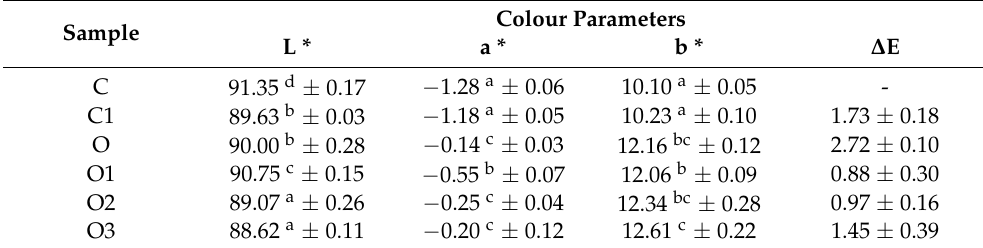
Table 2. Colour parameters and the total colour difference parameter in yoghurts obtained without or with the addition of tea. C, control; C1, control with 6% inulin; O, oolong tea; O1, oolong tea with 3% inulin; O2, oolong tea with 6% inulin; O3, oolong tea with 9% inulin. Colour Parameters Sample L * a * b * ∆ E C 91.35 d ± 0.17 − 1.28 a ± 0.06 10.10 a ± 0.05 - C1 89.63 b ± 0.03 − 1.18 a ± 0.05 10.23 a ± 0.10 O 90.00 b ± 0.28 − 0.14 c ± 0.03 O1 O3 1.45 ±